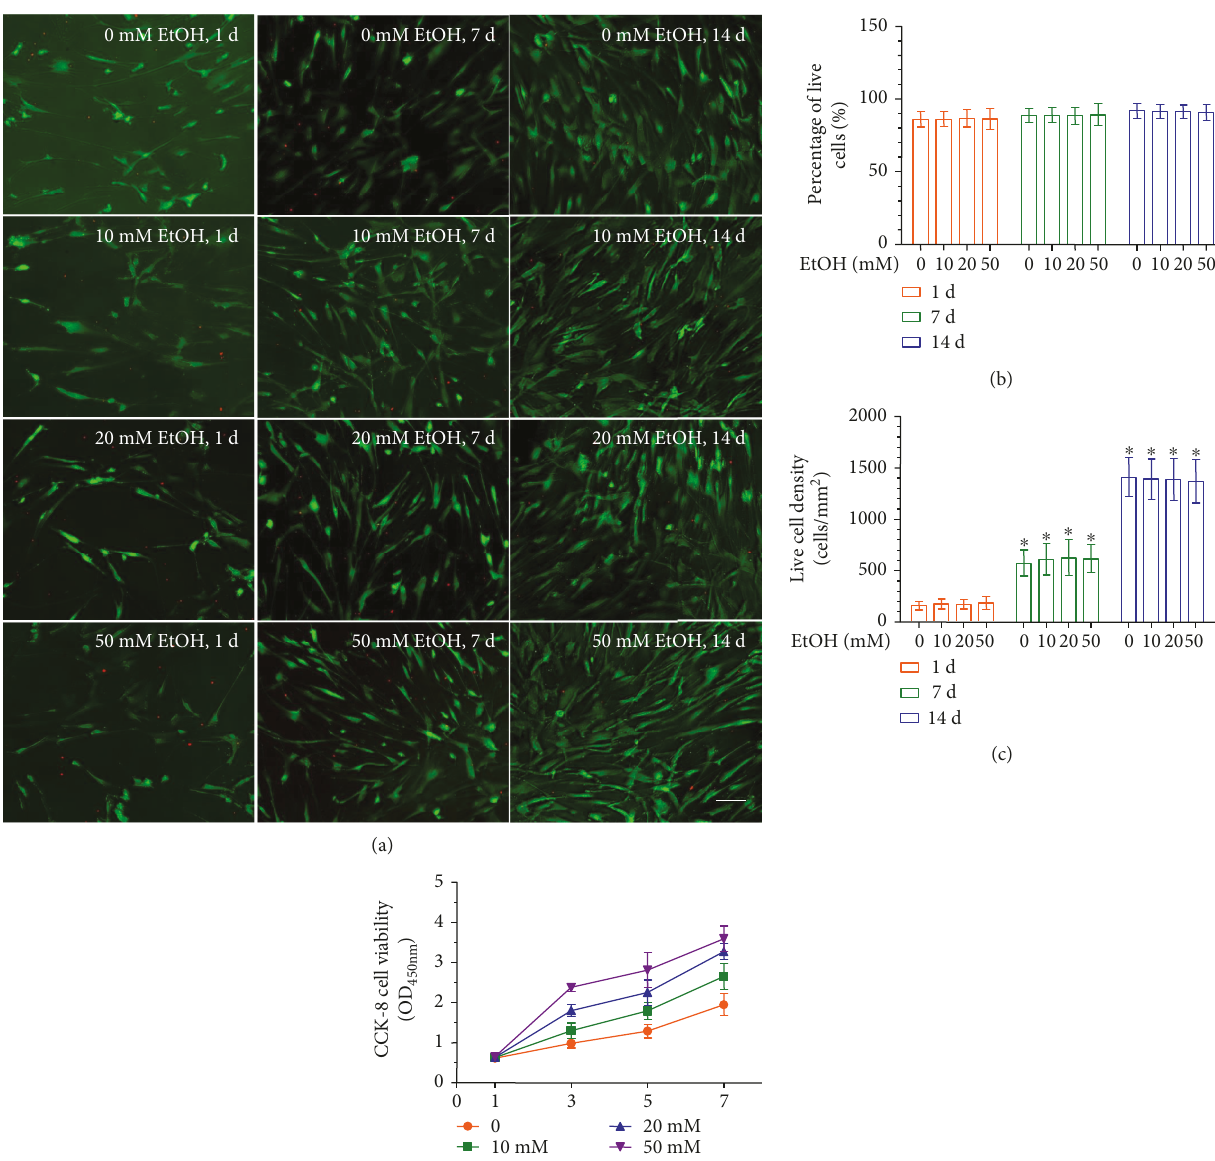
Figure 2: E ff ect of EtOH on cell viability and proliferation of DPCs. (a) Representative live/dead images of EtOH-treated DPCs after days 1, 7, and 14 of culture. Live cells were stained in green and dead cells were stained in red. In all four groups, live cells were abundant, and dead cells were few (scale bar =50 μ m). (b) Percentage of live cells of DPCs was around 90%. Data represent mean ± SD of 3 experiments with triplicates. (c) EtOH increased the cell proliferation. Data represent mean ± SD of 3 experiments with triplicates. ∗ p < 0 05 versus control